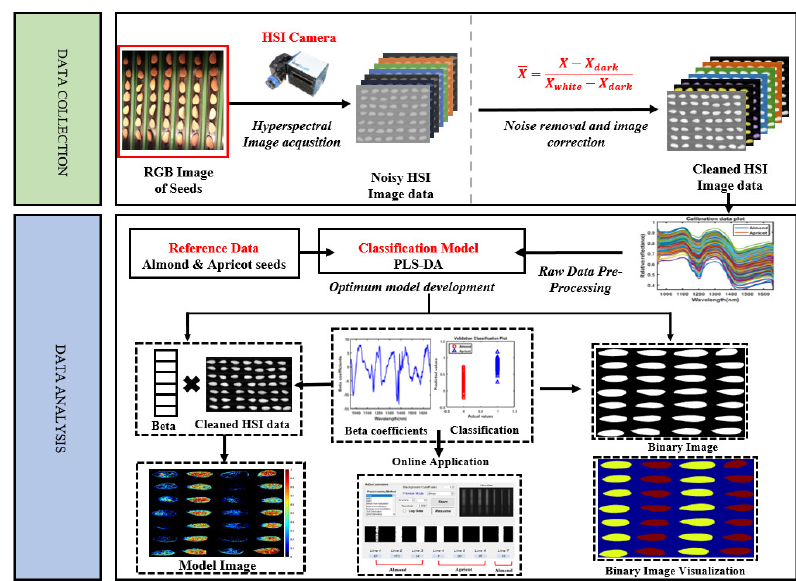
Figure 2. A schematic flow from data collection to the final online sorting application.